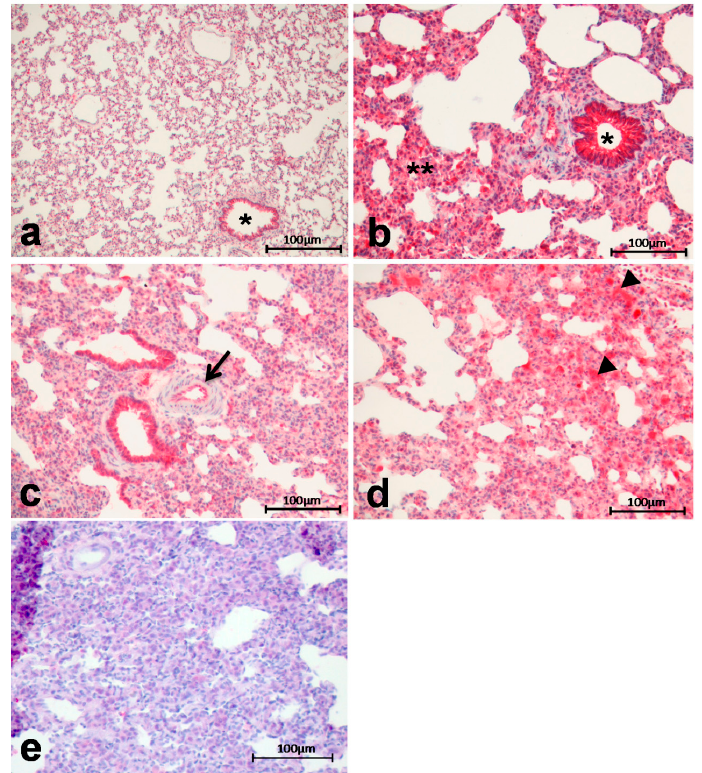
Figure 3. Arg II exhibited a distinct increase in expression and tissue deposition in IPH rats ( b – d ) compared to controls (( a ), * = bronchiolus) in particular in the lung parenchyma (**) and the epithelium of the bronchioles (*) ( b ), the endothelium of peribronchial arteries (( c ), arrow) and in alveolar macrophages (( d ), arrowheads = alveolar macrophages); negative control ( e ).